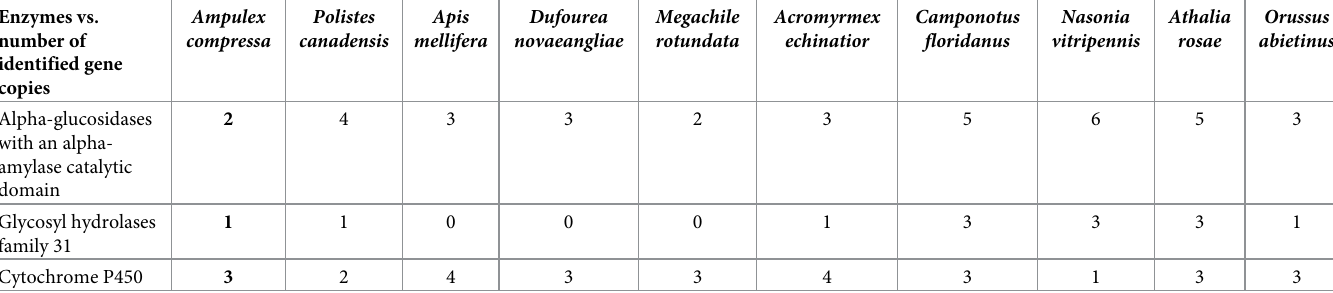
Table 10. Significant matches of identified glucosidase and cytochrome P450 gene copies found in A . compressa and other Hymenoptera species. Enzymes vs. number of